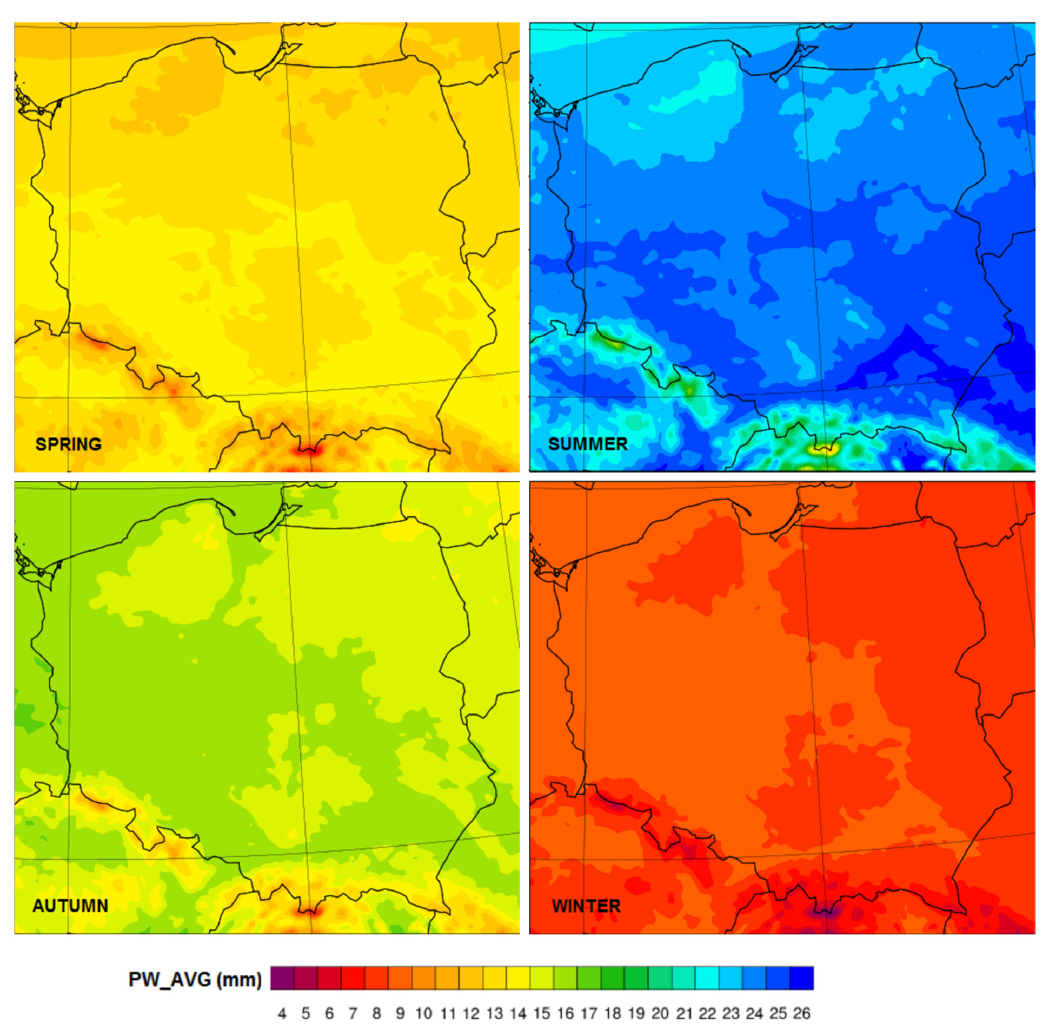
Figure 7. PW seasonal values (mm) over Poland for the years 1983–2010.